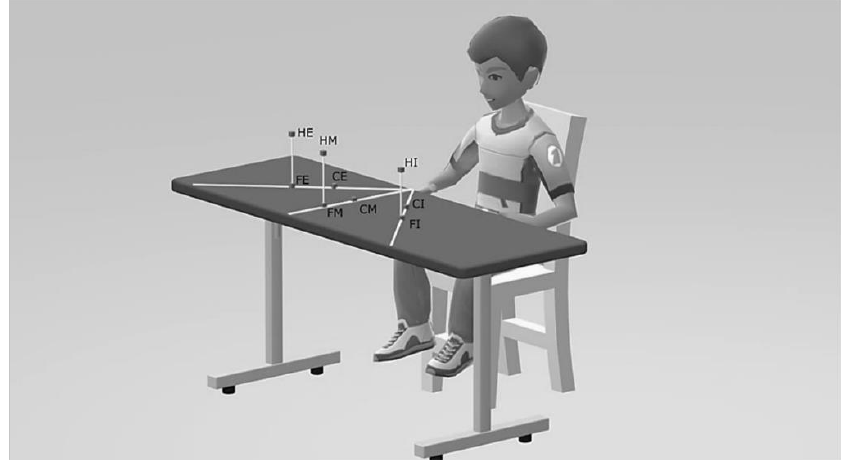
Figure 1. Schematic of the experimental setup. Target positions are indicated as: close-middle (CM), far-internal (FI), high-external (HE), far-middle (FM), close-external (CE), high-internal (HI), close-internal (CI), far-external (FE), and high-middle (HM).